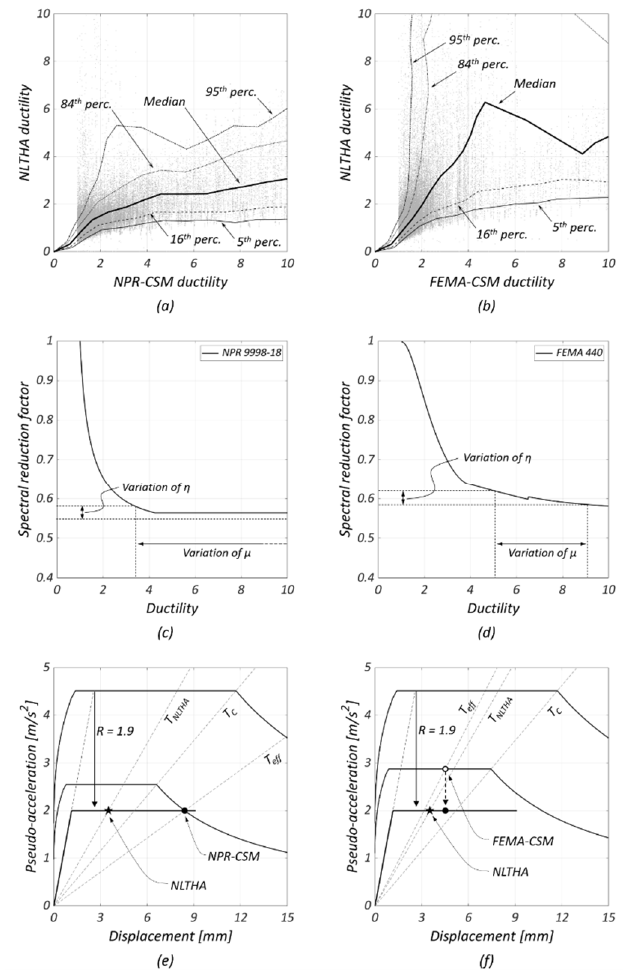
Figure 7. Comparison between ductility demand predictions from CSM and NLTHA on systems with T NLTHA < T C from Suite 1-A: ( a ) NPR 9998-18, and ( b ) FEMA 440. Relationships between spectral reduction factor and ductility according to ( c ) NPR 9998-18 and ( d ) FEMA 440. Application of the CSM to a system with T NLTHA < T C : ( e ) NPR 9998-18, and ( f ) FEMA